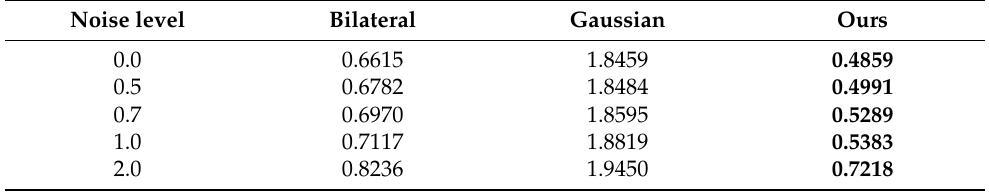
Table 1. The quantitative errors of the models used in this experiment. The first column is the noise level. Columns 2, 3 and 4 are the results of the mean-squared error (MSE) [40] between the noisy models and filtered